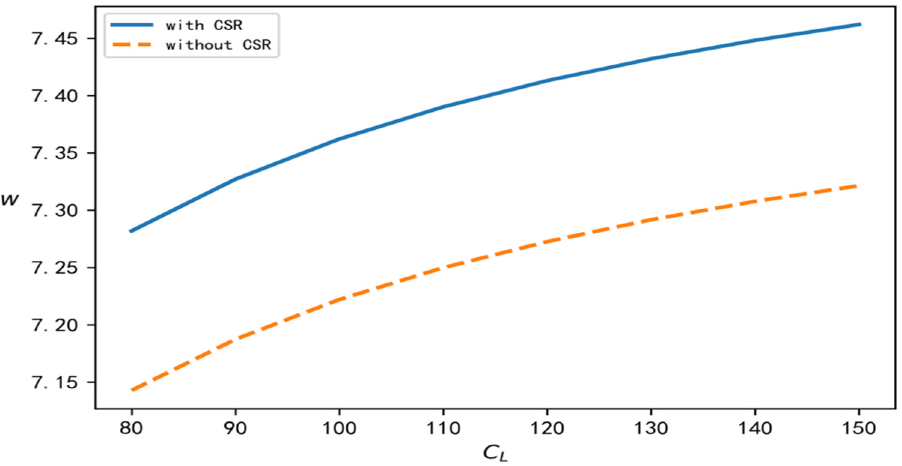
Figure 5. Change trend of the wholesale price.